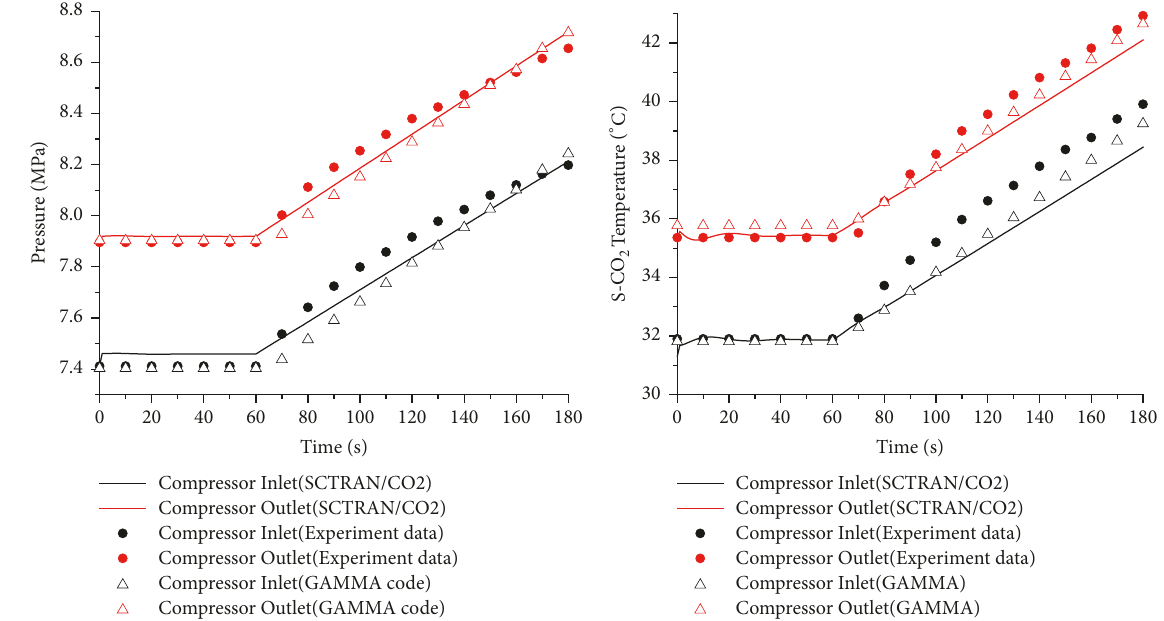
Figure 14: Pressure and temperature variation during the cooling reduction